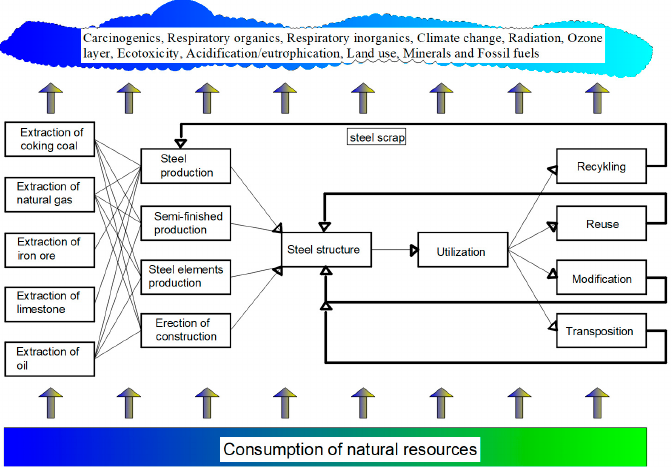
Figure 1. Life cycle of a steel Figure 1 . Life cycle of a steel structure.